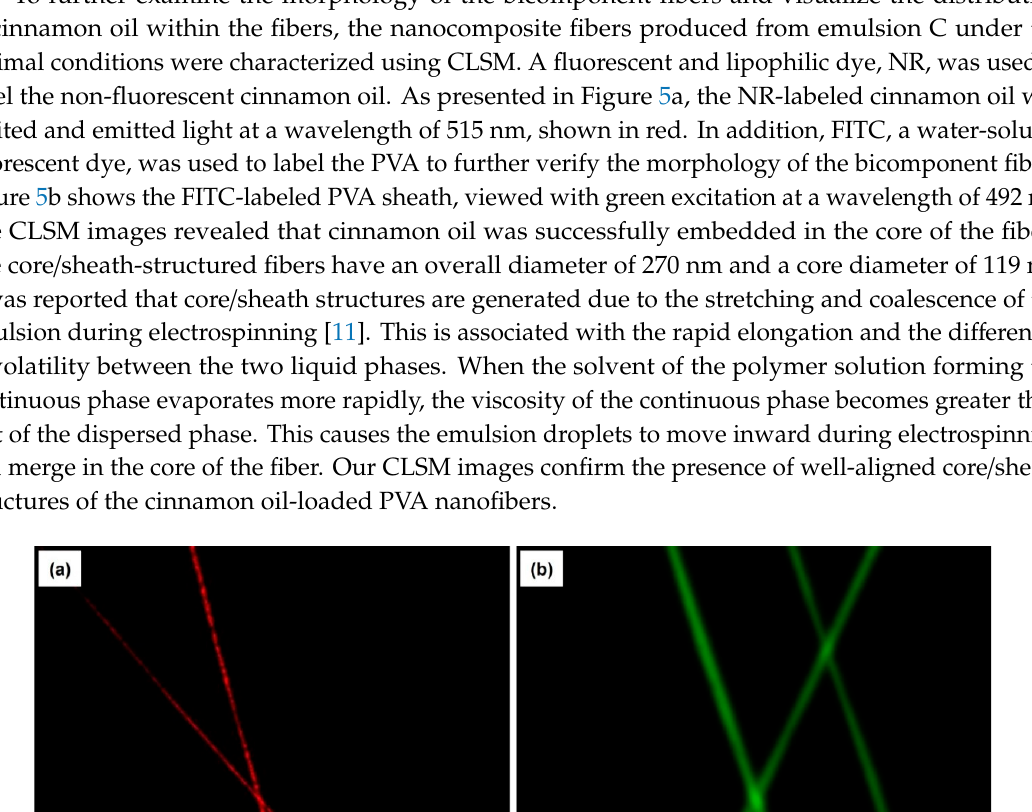
Figure 4. SEM image of cinnamon oil/PVA nanofiber webs from emulsion C (12 wt% of PVA, 4.29 wt% of cinnamon oil, and 0.86 wt% of surfactant) produced with a solution feed rate of 0.2 mL/h, a voltage of 25 kV, and a tip-to-collector distance of 20 cm through a 23-gauge needle.